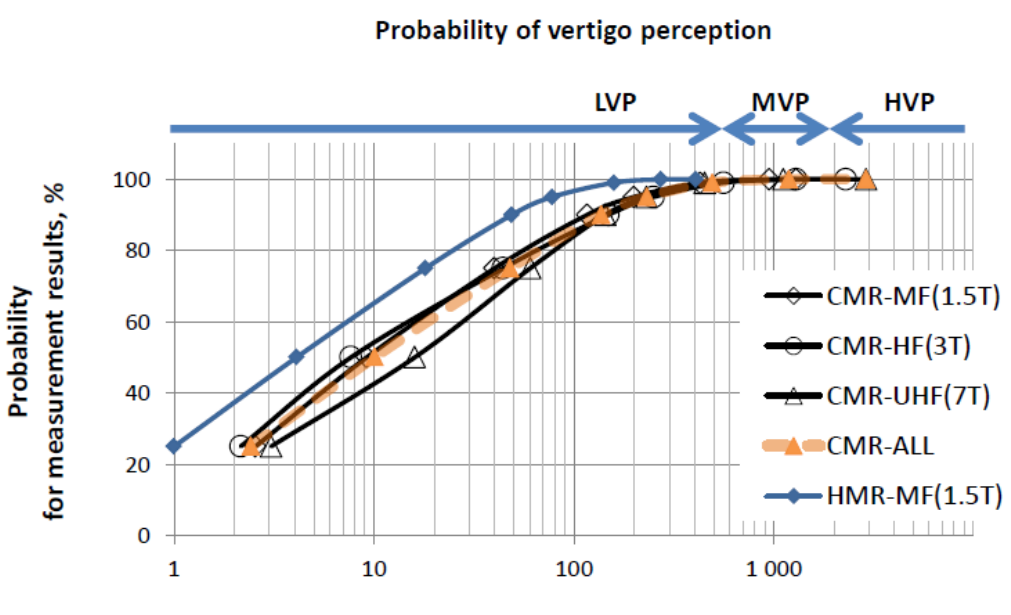
Figure 5. The distribution of the results of measurements collected by an exposimeter during the performance of 42 modelled CMR and 13 real head MRI radiographer exposure evenats (REEs). Time-variability of exposure caused by movements near MRI magnets, TVEmt in mT/ s, and relevant evaluation of the probability of vertigo perception at such exposure (LVP, MVP and HVP as shown in Table 1 regarding a peak value over the shift, PdB/dt@s).